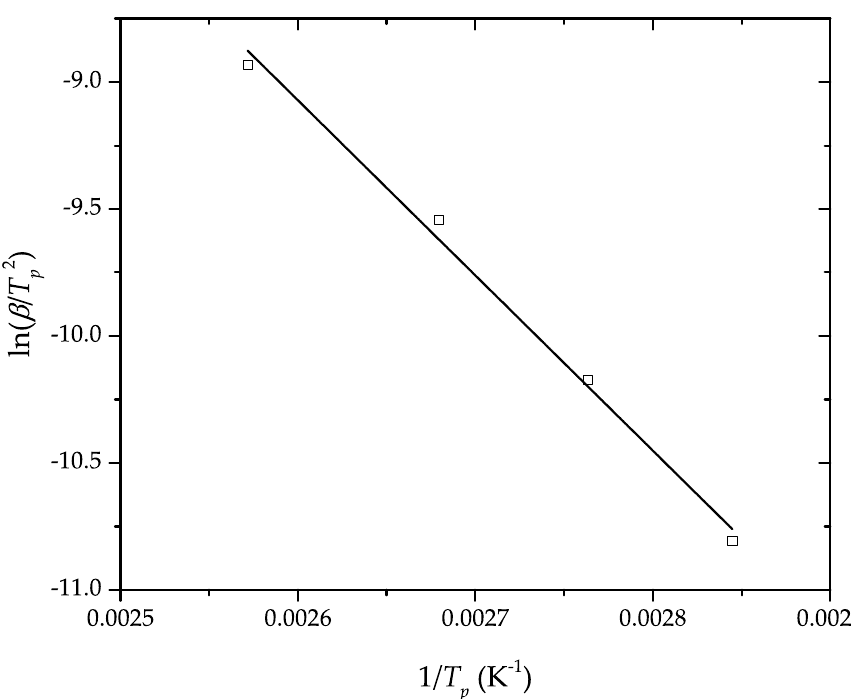
Figure 5. Plot of the experimental data according to the Kissinger method and the linear fitting according to Equation (15) corresponding to the crosslinking of a partially bio ‐ based epoxy resin for different heating rates, β .